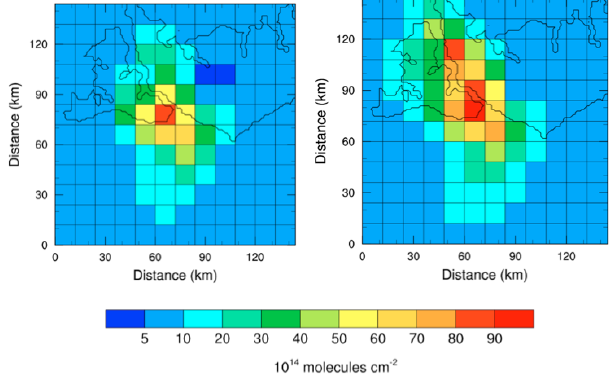
Fig. 16. Partial NO 2 columns from the tropopause (105mb) to 400mb (left) and 600mb (right) for the simulated Hector thun- derstorm at 14:45LT. Each column covers 12 × 12km 2 area. The tropopause height is estimated based on the idealized sounding and the climatological mean pressure of the lapse-rate tropopause from radiosonde data (Seidel et al., 2001).